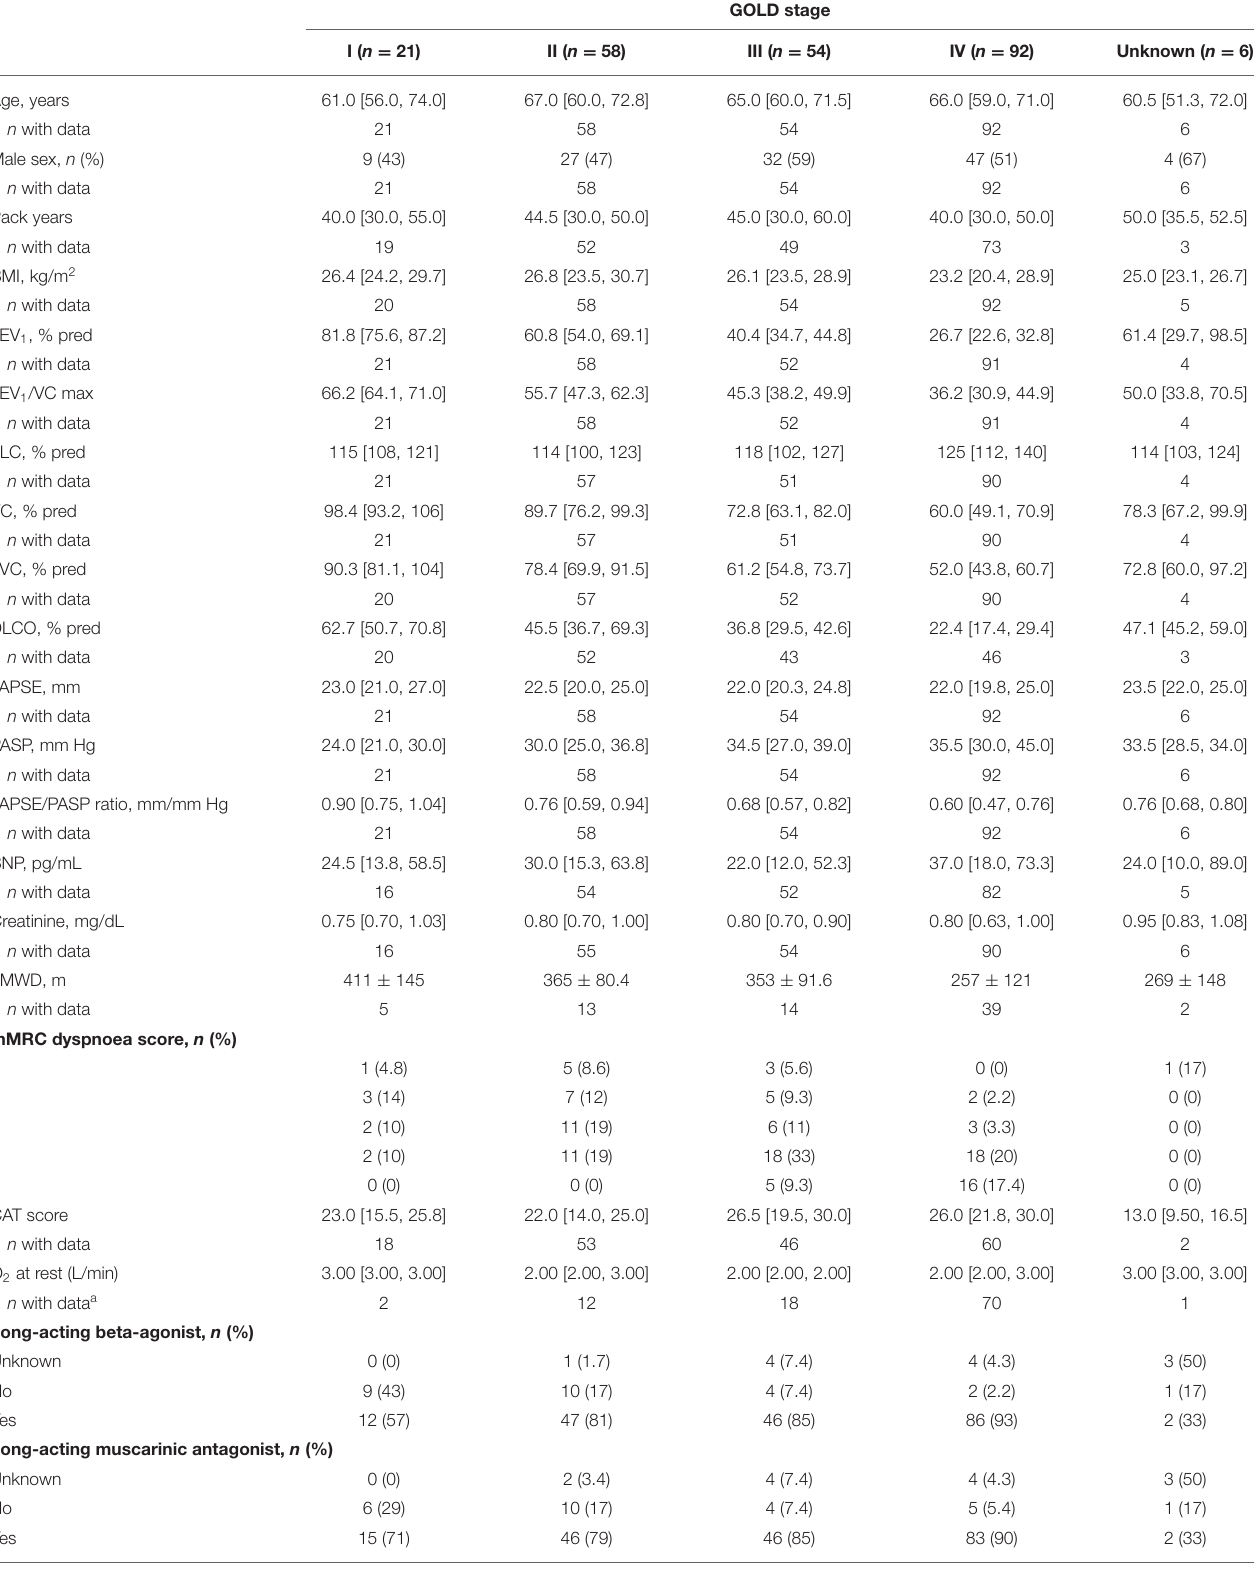
TABLE 1 | Baseline characteristics of patients with COPD without pulmonary